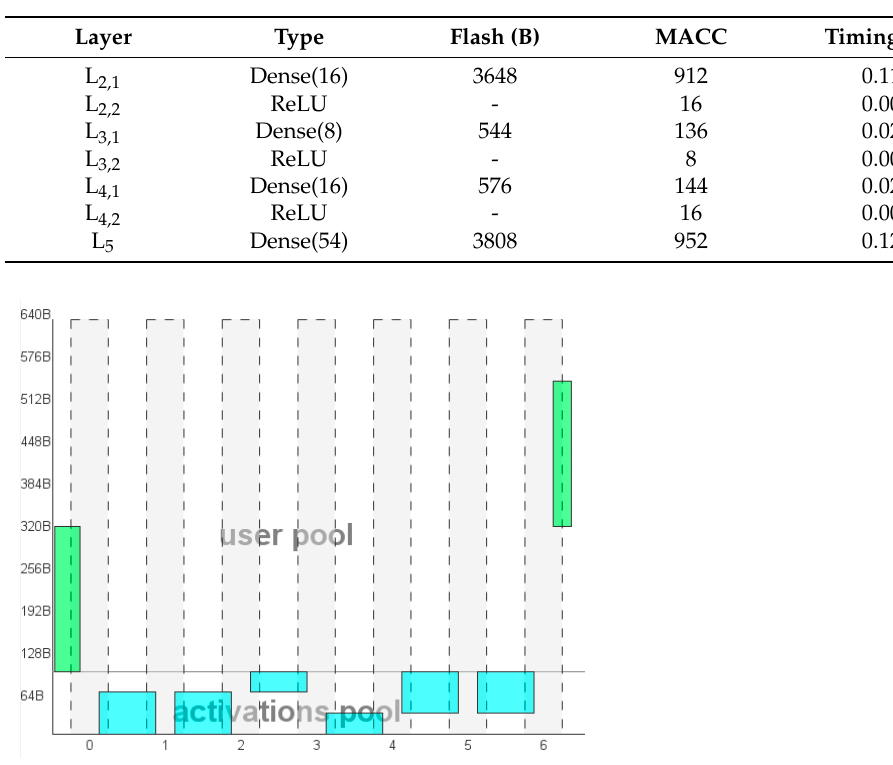
Table 7. Autoencoder layers’ ROM utilization and MACC.